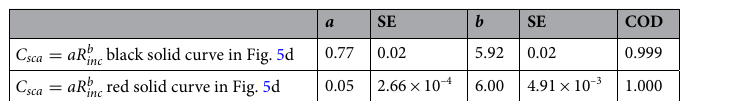
a SE b SE COD C sca = aR b inc black solid curve in Fig. 5d 0.77 0.02 5.92 0.02 0.999 C sca = aR b inc red solid curve in Fig. Table 2. Fitting parameters. SE standard error, COD coefficient of determination.